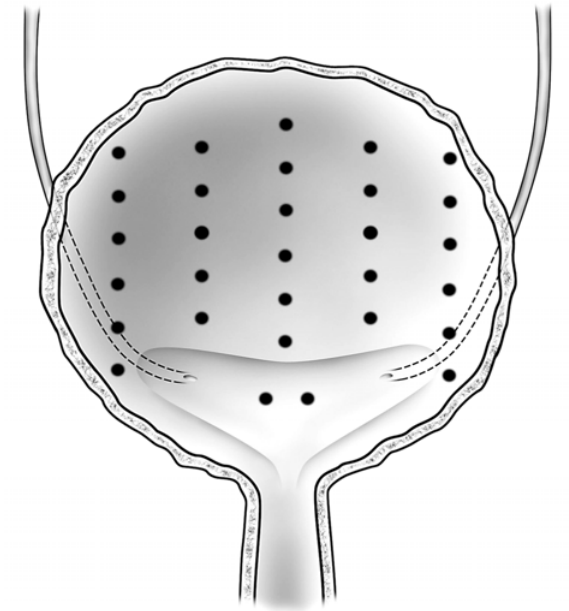
Figure 2 – University of Chicago botulinum toxin injection protocol (Reprinted with permission from Elsevier Inc, Urology, Rapp DE et al., ref.